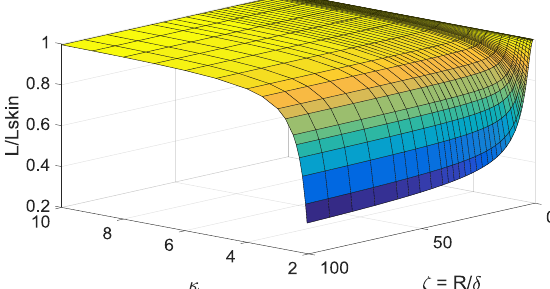
Figure 3: Pseudo 3D plot of the final ratio 𝐿/𝐿 𝑠𝑘𝑖𝑛 in func- tion of the dimensionless parameters 𝜅 and 𝜁 .